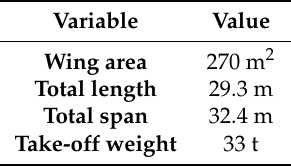
Table 1. Main characteristics of the Hybrid-Electric-Propelled (HEP) regional Blended-Wing-Body (BWB).